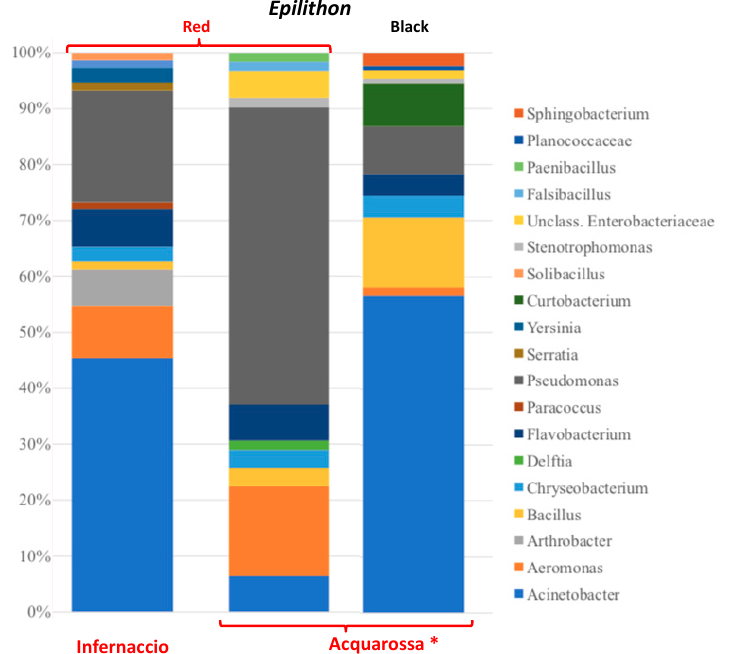
Figure 2. Composition of bacterial communities isolated from red epilithons of Infernaccio and Acquarossa river and black epilithon from Acquarossa river. * Data from [3].